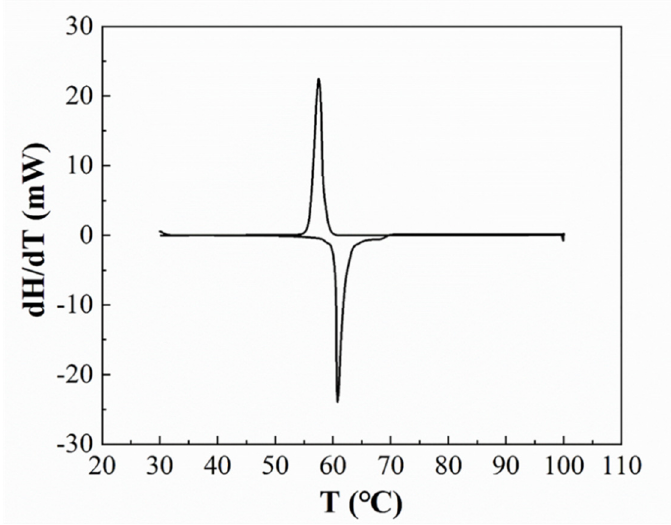
Figure 3. The DSC curve of 13.5Sn-37.5Bi-45In-4Pb solder paste.